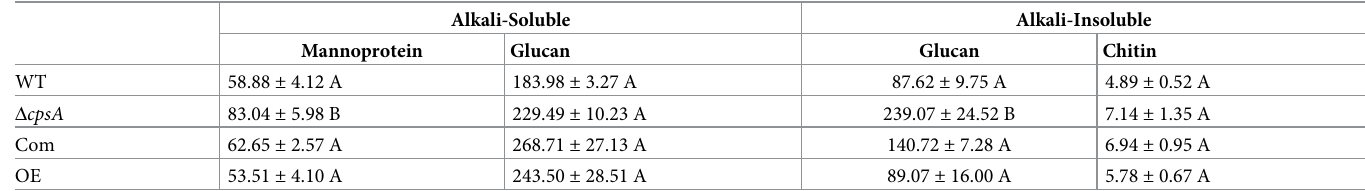
Table 3. Cell wall composition ( μ g/mg ± standard error).